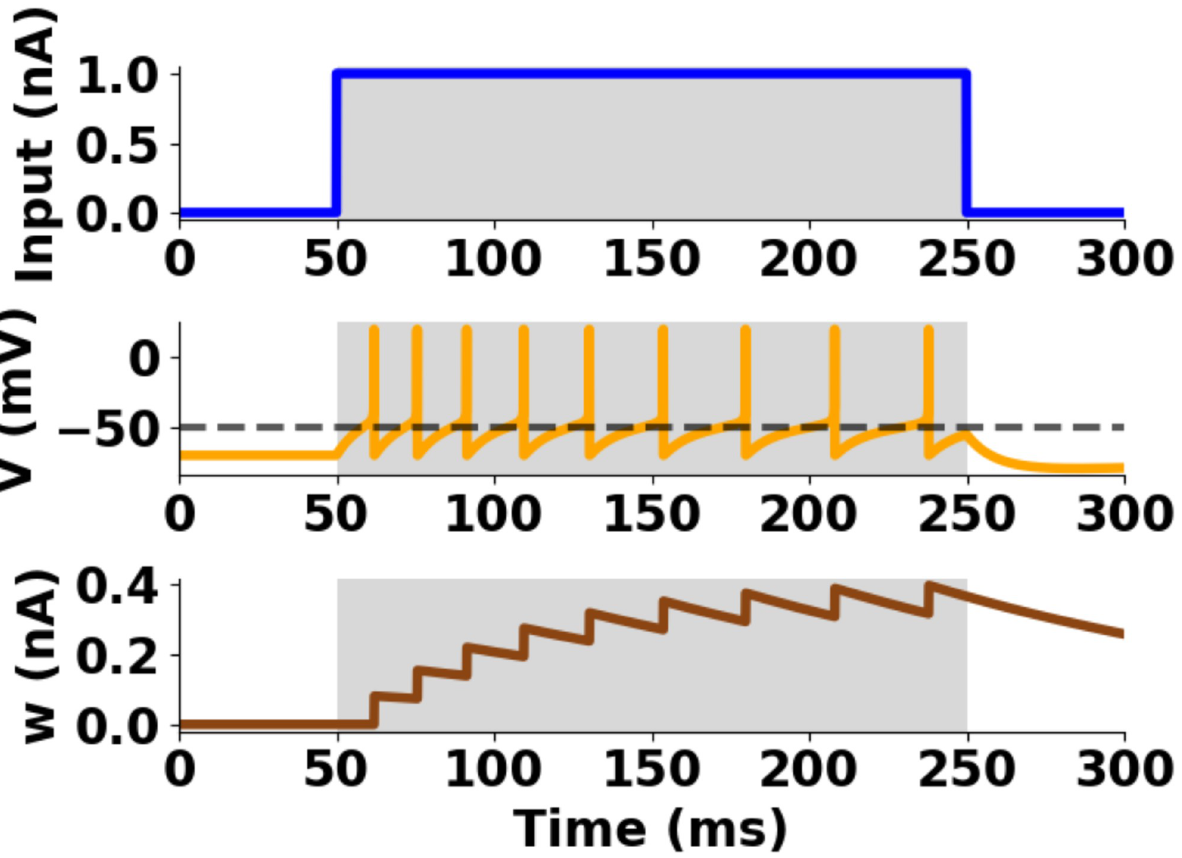
Fig 4. Single unit profile of the aEIF model. Postsynaptic spikes from input current injection. Top: input current, Middle: membrane potential, Bottom: adaptation variable. Parameters: C m = 281 pF, g L = 30 nS, E L = − 70.6 mV, V T = − 50.4 mV, V peak = 20 mV, Δ T = 2 mV, τ w = 144 ms, a w = 4 nS, b w = 0.0805 nA, τ syn = 5